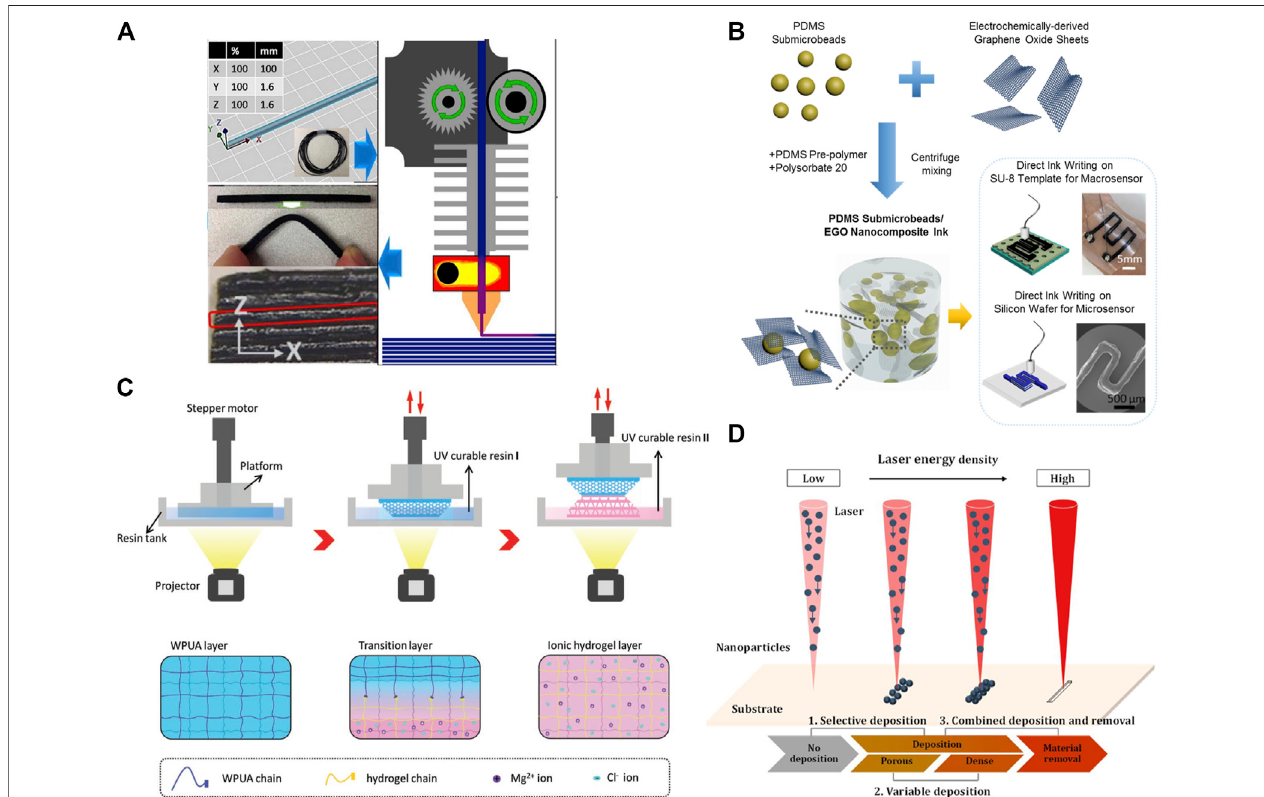
FIGURE1| Theprocess forpreparingstrainsensorusing (A) FFF(Christet al.,2017), (B) DIW(Shietal.,2019), (C) DLP (Yinet al.,2019),and (D) SLS(Songet al., 2020).